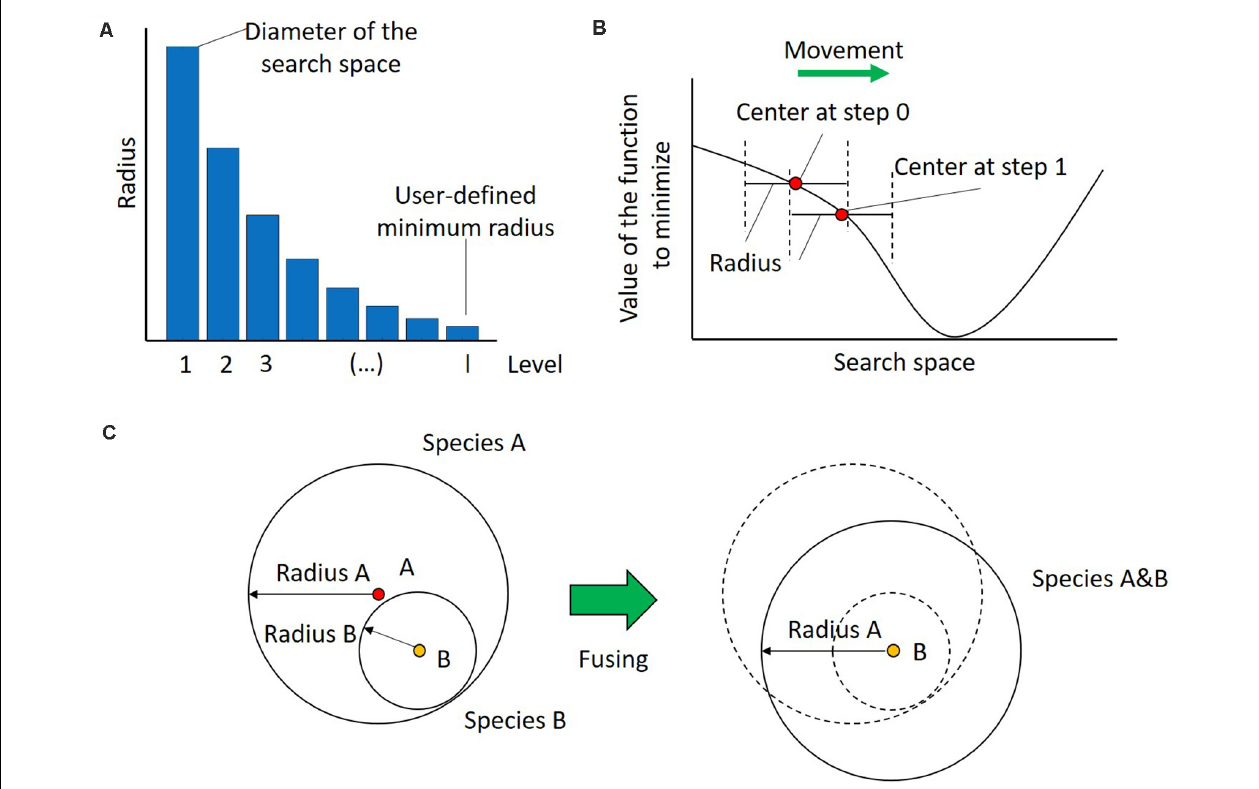
FIGURE 3 | Dynamics in UEGO. (A) Evolution of the radius length linked to the species created at every level or cycle. The radius of the first level, i.e., that assigned to the initial species, is equal to the diameter of the search space. Subsequent radii decrease in geometrical progression until the last one, which corresponds to the minimum radius defined by the user to consider different solutions. By proceeding this way, species of the first cycles have more mobility, which promotes exploration of the search space, and those of the last levels have more exploitation, which helps convergence. (B) Movement of a species in a hypothetical single-dimension search space after an iteration of the local search method. The whole species is moved after finding a better center. Notice that the new point falls within the original region defined by the species, but its new position also moves the search focus. (C) Fusing species. On the left two overlapping species, A and B, with radii Radius A and Radius B, respectively. On the right, the species A&B that results from their fusion. This new species keeps the largest radius of both, i.e., Radius A, which aims to keep the regions to explore as broad as possible to avoid premature convergence. Additionally, take into account that since the center of Species A&B is that of B, it can be concluded that Species B has a better, i.e., lower value of the cost function. Finally, notice how the new species has slightly moved from the original zones, so it will be possible to explore a new zone of the search